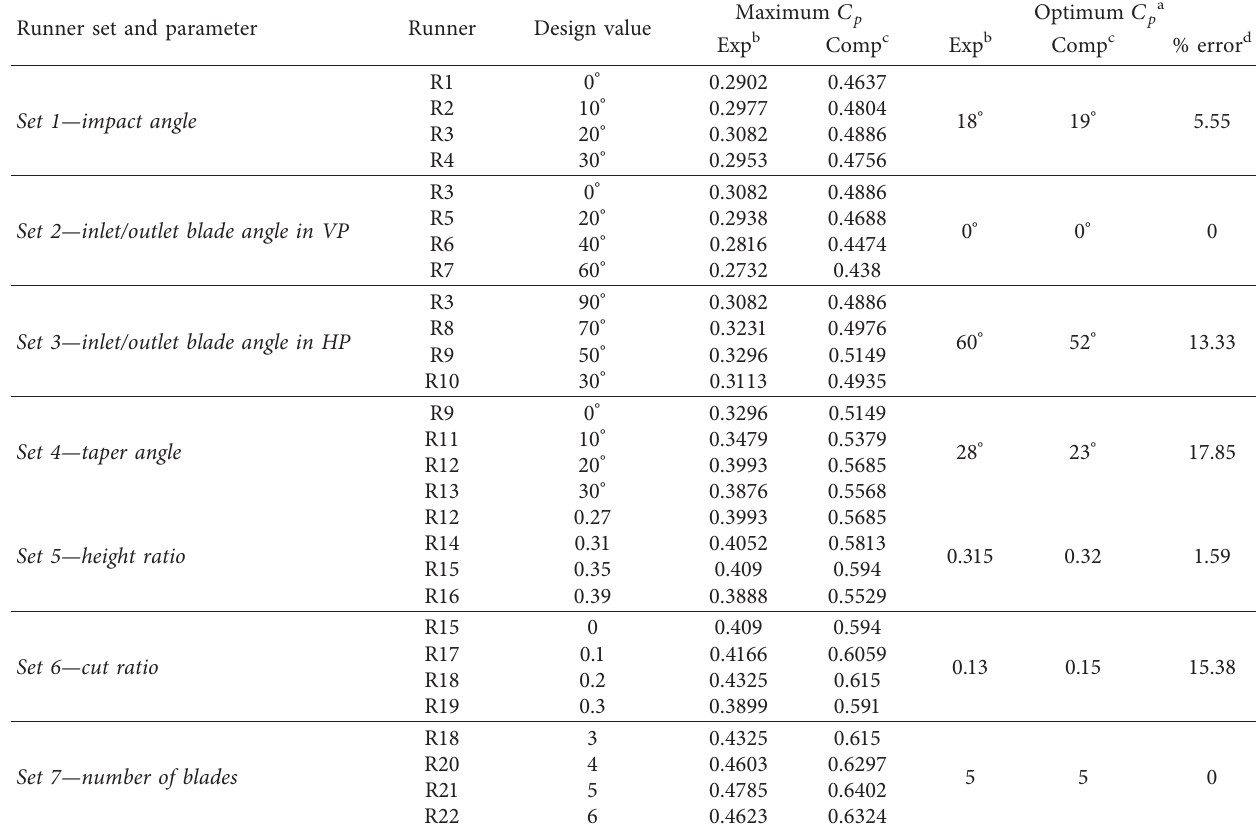
Table 3: Runner sets with their design parameter values and optimum